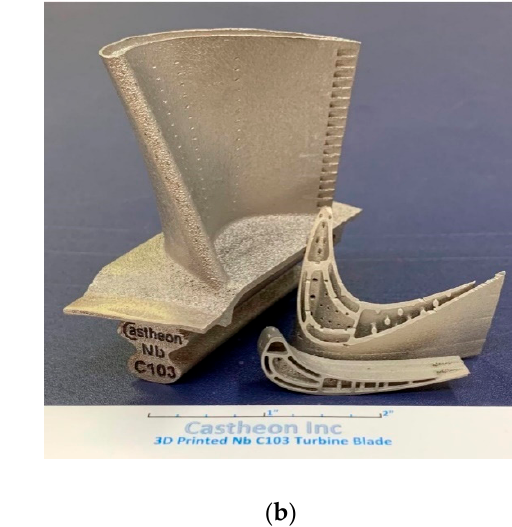
Figure 2. Metal and ceramic turbine blades produced via new manufacturing processes [13,14], and more in [15]. ( a ) Rotor Blades, ( b ) Airfoil with complex cooling features (courtesy: Castheon Inc.)